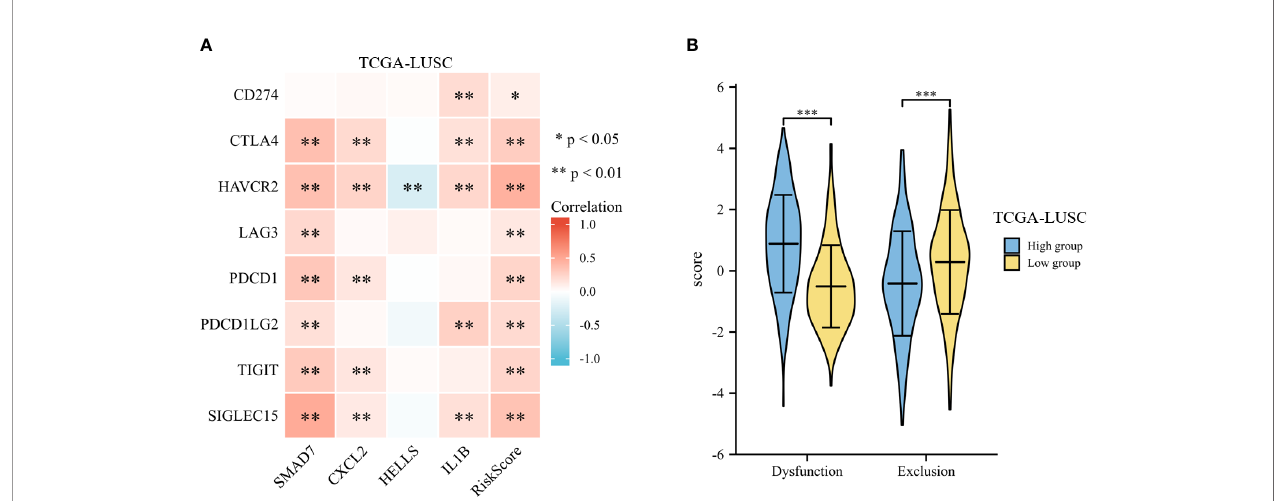
FIGURE 10 | Immunotherapy response of LUSC. (A) The heatmap of expression of risk score and selected immune-checkpoint-relevant genes. (B) The violin plot for the TIDE scores between the high- and low-risk groups. *p < .05, **p < .01, and ***p <